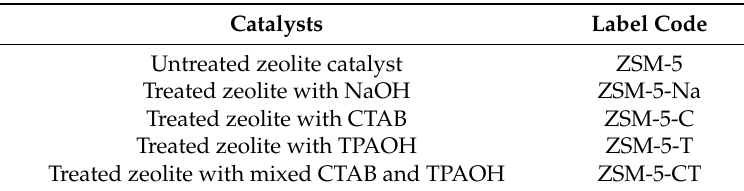
Table 1. Zeolite catalyst coding. Catalysts Label